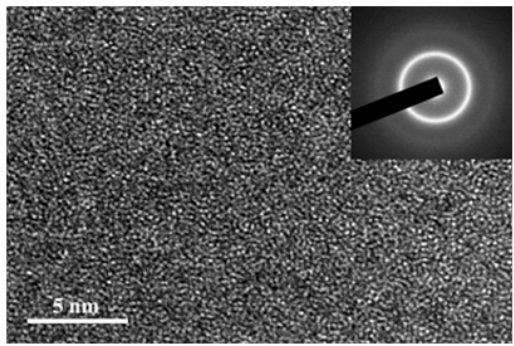
Figure 3. The HRTEM image of the Fe 78 Zr 8 B 4 Mn 10 amorphous alloy. The relationship between magnetization ( M ) and temperature ( T ) of the amorphous Fe 88 − x Zr 8 B 4 Mn x samples was measured, respectively, from 200 to 380K after the operation by a zero-field cooling method. By performing a derivative process on the curves in Figure 4, the Curie temperature of a series of Fe 88 Zr 8 B 4 samples with Mn addition was found to be 283 K for x = 2, 263 K for x = 5, 238 K for x = 8 and 225 K for x = 10. The T c of the metallic glasses with Mn added, as seen in the embedded image in the upper right corner of Figure 4, had a decreasing trend compared with the Fe 88 Zr 8 B 4 samples. It is known that the magnetic properties of Fe-based amorphous alloys exhibit a close correlation with the direct 3d interactions of Fe atoms [19–23]. As with the situation shown in the FeZrB series amorphous alloys, although the reduction of Fe content reduces the number of interactions between 3d atoms, the introduction of other atoms can enhance the 3d interaction between Fe to some extent and thereby enhance the magnetic properties of the FeZrB amorphous alloys. A completely different trend of the Mn addition on the Fe-Zr-B amorphous alloys, however, induced antiferromagnetic coupling between Fe and Mn atoms [29], which deteriorated the Fe-Fe interactions and therefore led to a decrease in the Curie temperature of the Fe 88 Zr 8 B 4 metallic glass.